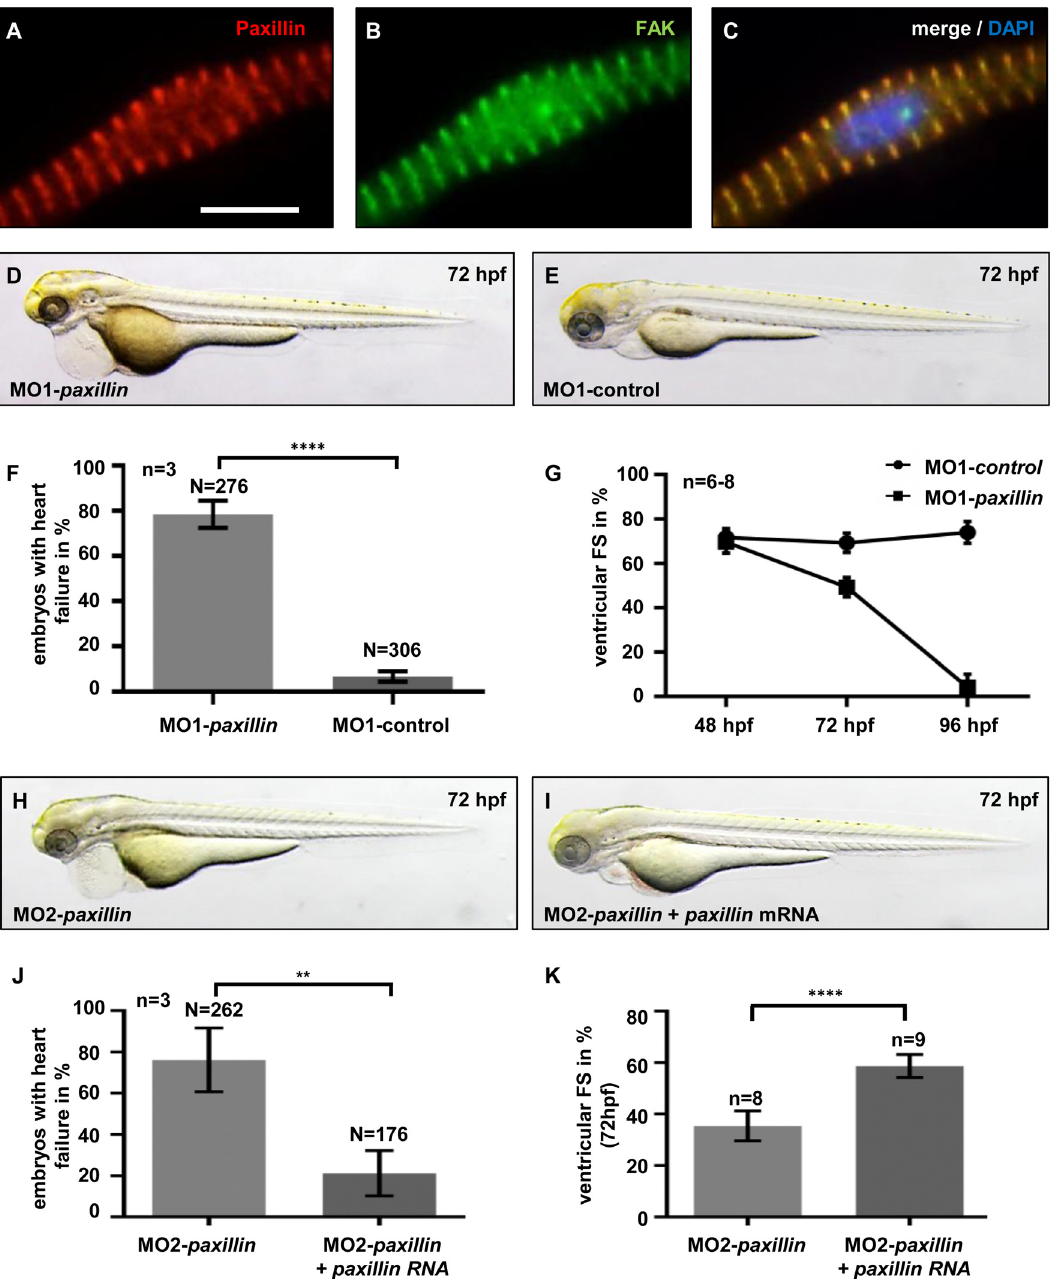
Fig 1. Targeted knock-down of Paxillin leads to heart failure in zebrafish. (A-C) Co-immunostaining of Paxillin (A, red) and the known Z-disk protein Focal Adhesion Kinase (FAK) (B, green) on adult primary zebrafish cardiomyocytes revealed localization of Paxillin to sarcomeric Z-disks. Cell nuclei were counterstained with DAPI (C, blue). Scale bar 10 μ m. (D-G) Lateral view of paxillin start MO (MO1- paxillin ) (D) and paxillin 5bp-mismatch-MO (MO1-control) (E) injected embryos at 72 hpf. (F) 78% of embryos injected with 5.4 ng MO1- paxillin developed pericardial edema and blood congestion at the cardiac inflow tract (n = 3; * P < 0.0001), whereas control-injected embryos developed no pathological phenotype. (G) Fractional shortening (FS) measurements of Paxillin morphant ventricles at 48, 72 and 96 hpf. FS of Paxillin morphant ventricles was slightly reduced to 69.6% ± 5.07% compared to corresponding 5bp- mismatch-MO injected embryos (FS: 71.6% ± 3.96%) at 48 hpf. At 72 hpf, FS in Paxillin morphants was reduced to 49.29% ± 4.39% compared to control morphants (FS: 69.3% ± 4.36%), whereas ventricular chambers of Paxillin morphants became almost silent (FS: 4.23% ± 6.17%) compared to controls (FS: 74% ± 4.96%) at 96 hpf (n = 6 – 8 individuals per time point). (H-K) Lateral view of MO2- paxillin (H) and MO2- paxillin + paxillin mRNA (I) injected embryos at 72 hpf. (J) Co-injection of 4.5 ng of MO2- paxillin and 1 ng wild-type paxillin mRNA rescued the Paxillin morphant heart failure phenotype (n = 3; * P = 0.0073). (K) Quantification of ventricular FS revealed that ectopic expression of paxillin mRNA significantly improved contractile function in Paxillin morphants at 72 hpf (n = 8 – 9 individuals; * P < 0.0001). Error bars indicate s.d.